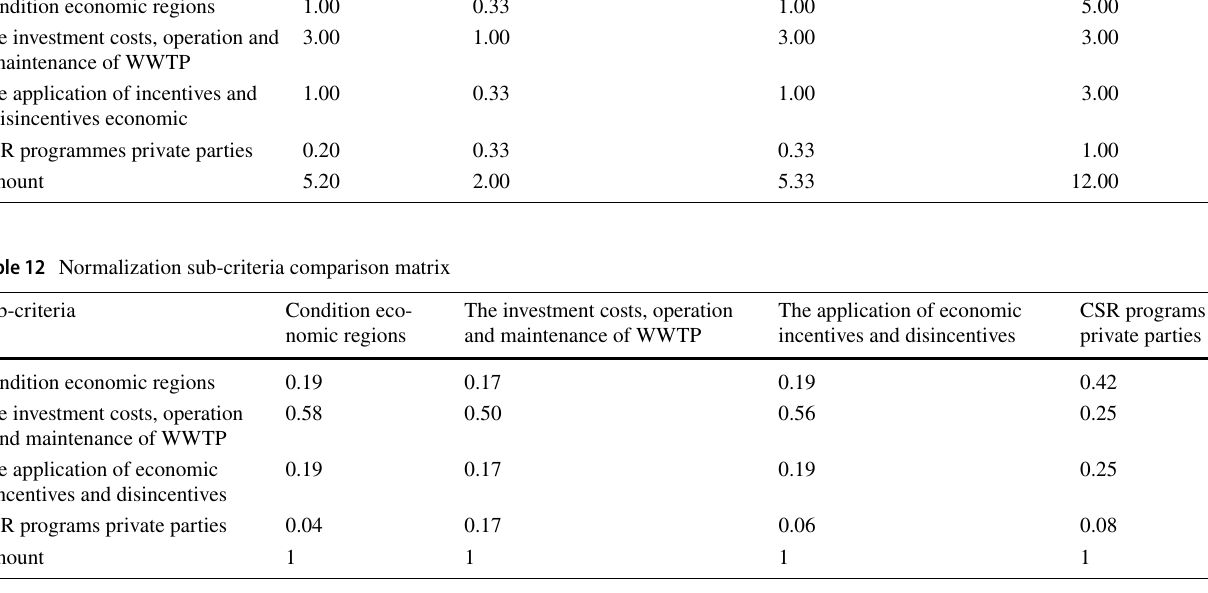
Table 13 Sub-priority criteria weighting